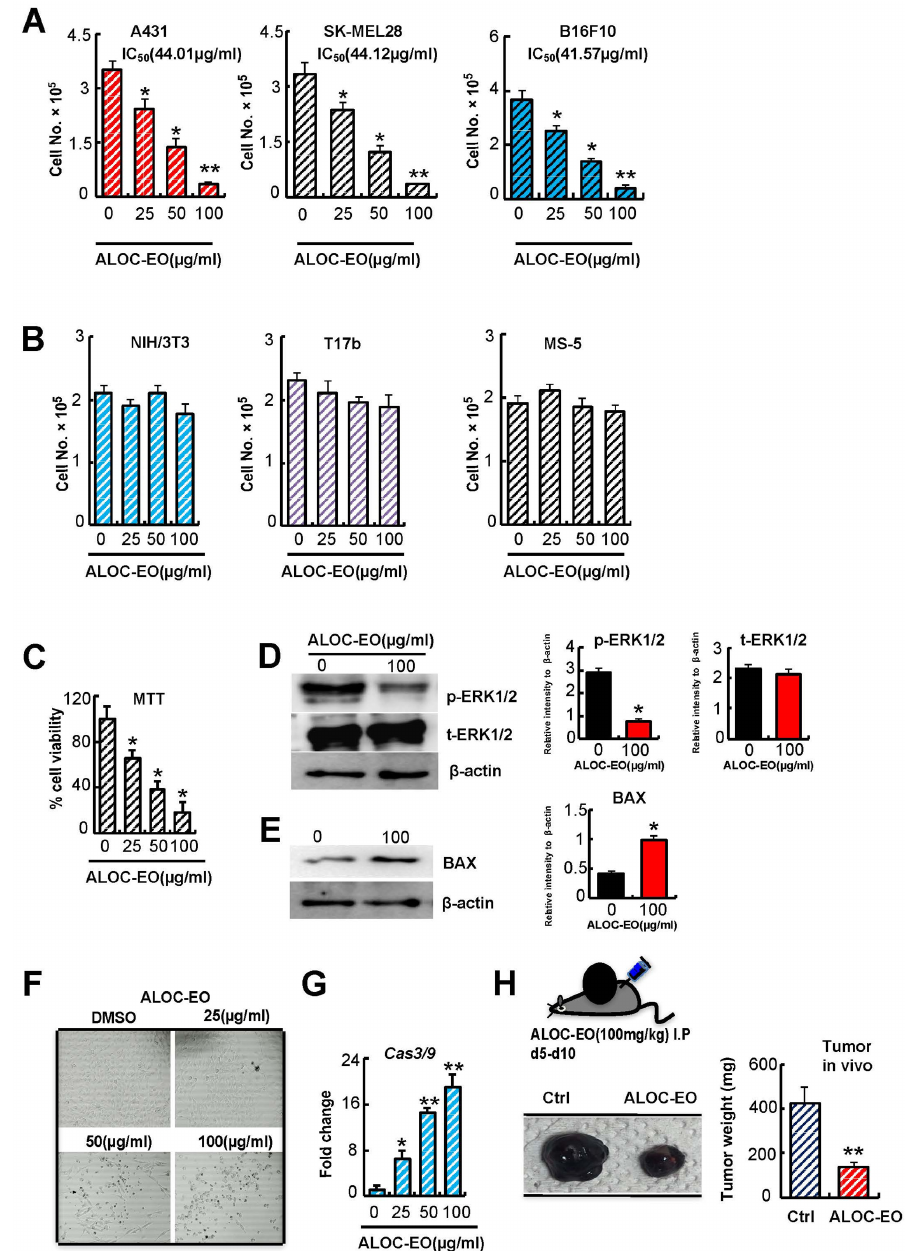
Figure 1. ALOC-EO is cytotoxic for melanoma cells. ( A ) The murine B16F10, human SK-MEL28, human epidermoid carcinoma cell line A-431, and ( B ) the murine fibroblast NIH/3T3, embryonic endothelial progenitor cells (T17b), or the stromal cell line MS5, were exposed to indicated concentrations of ALOC-EO for 24 h in a 5% CO 2 incubator at 37 ◦ C. Cells were counted using a hematocytometer (n = 6/group). The inhibitory concentration 50 (IC 50 ) for each cell line is given. ( C ) Cell viability of B16F10 cells exposed to indicated concentrations of ALOC-EO was determined using an MTT assay (n = 6/group). ( D ) Total ERK1/2 and phosphorylation of ERK1/2 in B16F10 cells treated with either DMSO (control) or ALOC-EO after 4 h (100 µ g/mL). β -actin served as a loading control. Left panel immunoblot. Right panel: The histograms represent the signal intensity of the indicated protein bands in arbitrary units after normalization with the signal intensity of β -actin internal control for each sample. Values are means and SEM of two independent experiments. ( E ) Representative immunoblots for BAX in untreated and ALOC-EO-treated B16F10 cell lysates. β -actin served as a loading control. Right panel: The histogram represents the signal intensity of the indicated protein bands in arbitrary units after normalization with the signal intensity of β -actin internal control for each sample. Values are means and SEM of two independent experiments. ( F ) Macroscopic images of B16F10